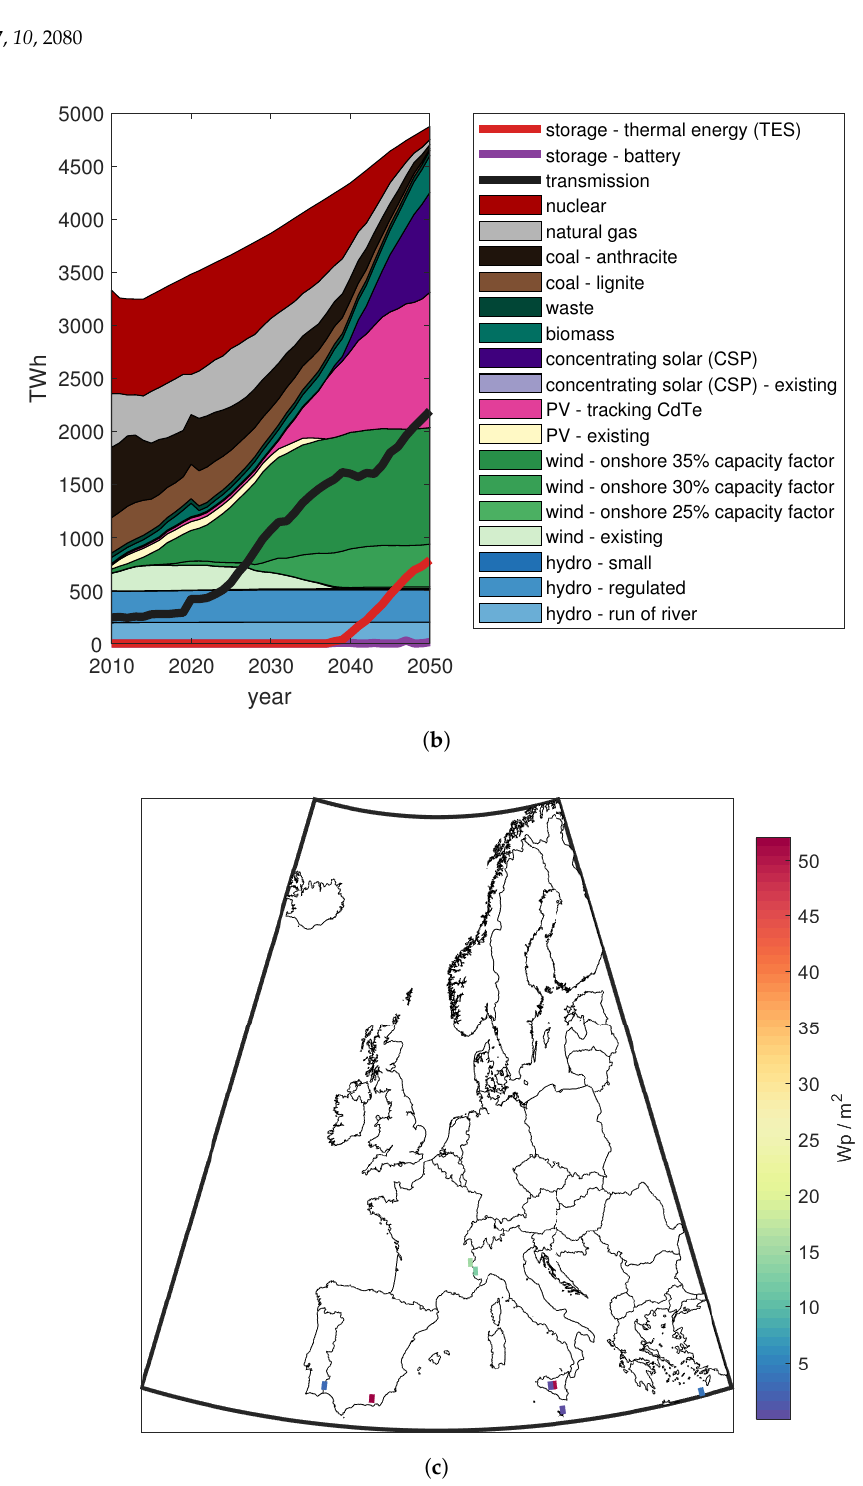
Figure 5. Model results for the lower CSP cost scenario including ( a ) the capacity of new transmission (GW p ) and storage (GWh) investments, ( b ) the electricity generated by generation type and year plus yearly electricity transmitted internationally and yearly energy transferred to storage, ( c ) the installed capacity of CSP. Note that the order of the legends for line and area plots corresponds to the order of the respective values in 2010 from top to bottom. Note also that the color of the regions/quadrants on map plots indicates the installed capacity density in the given region/quadrant where white signifies zero